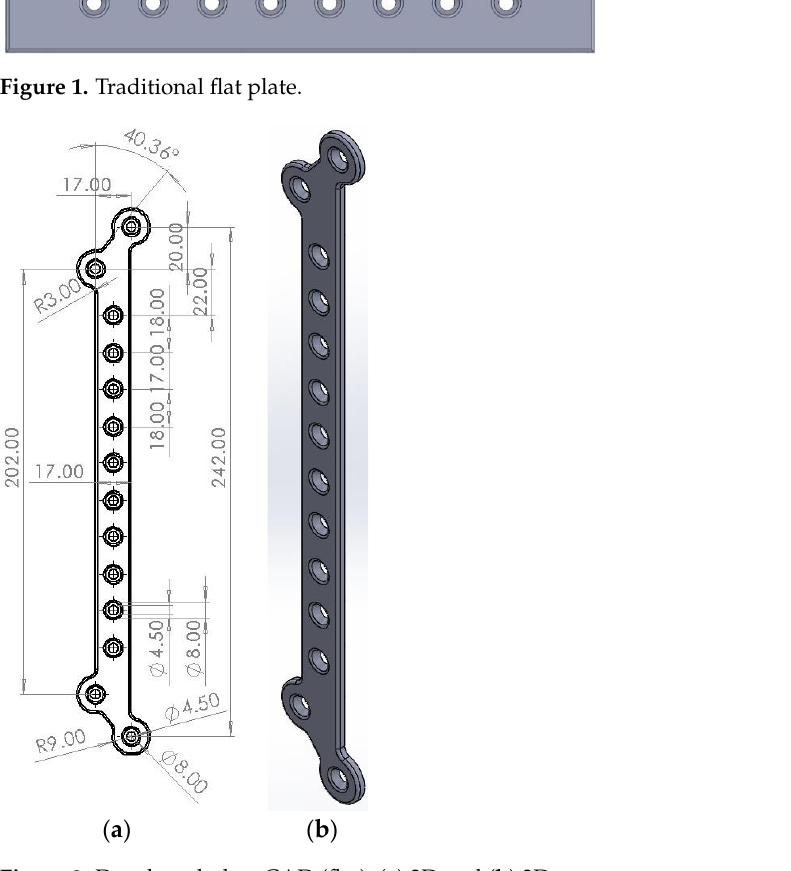
Figure 2. Developed plate CAD (flat); ( a ) 2D and ( b ) 3D.